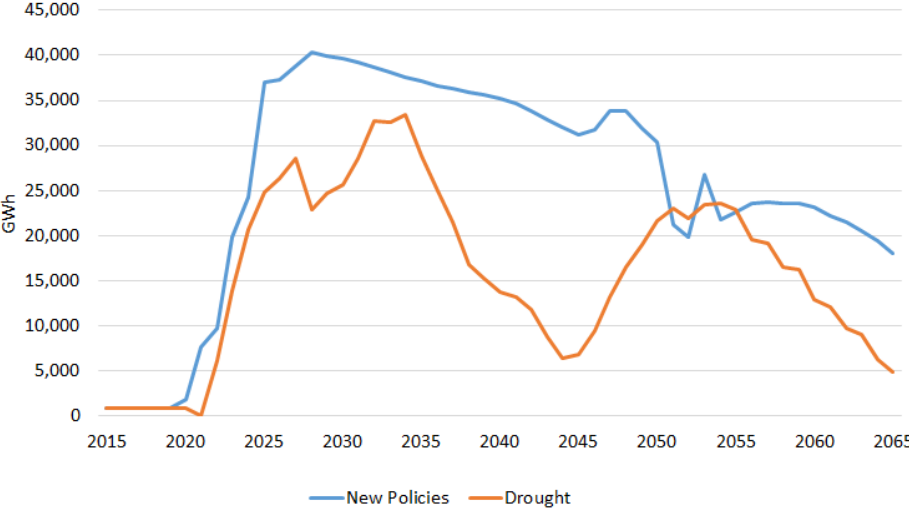
Figure 5. Comparison of electricity exports (GWh) between Drought and New Policy